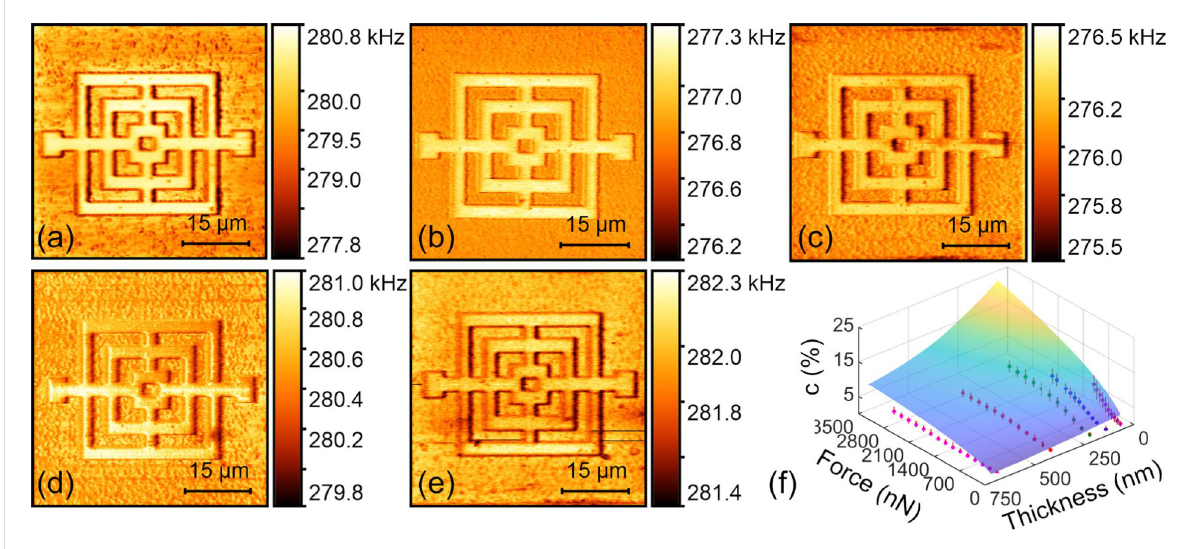
Figure 6: Influence of cover thickness on CR-AFM subsurface imaging of the circuit sample. (a–e) Frequency images of samples with the cover layer thicknesses of 52, 117, 185, 380 and 653 nm, respectively. The images were acquired by using the first eigenmode of the PPP-FM cantilever. The applied forces were 415, 376, 427, 441 and 400 nN, respectively. (f) Contact stiffness contrasts under different cover thicknesses and applied forces. The scatter plots denote the experimental results and the mesh surface is constructed from theoretical